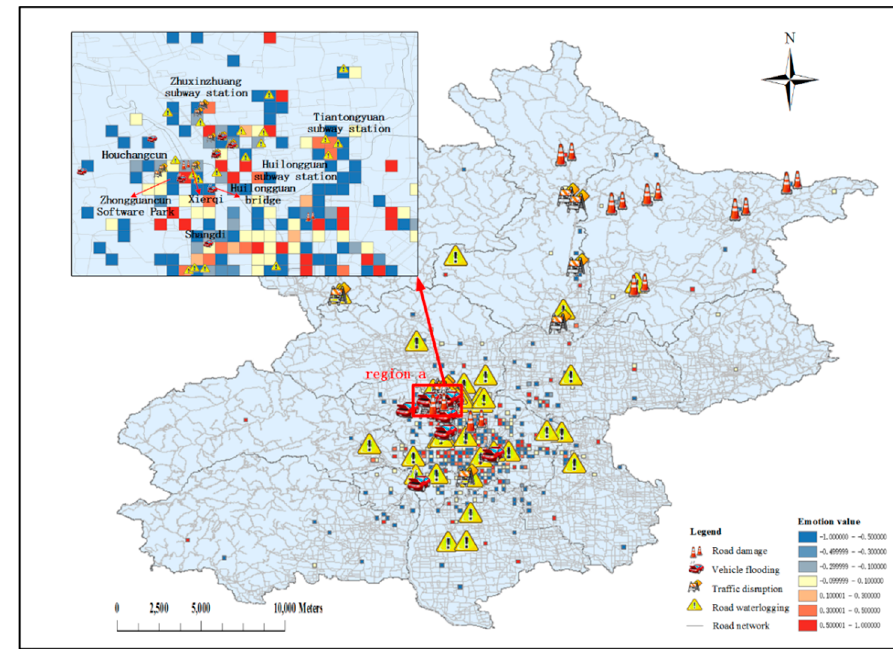
Figure 3. Distribution of traffic conditions in Beijing.